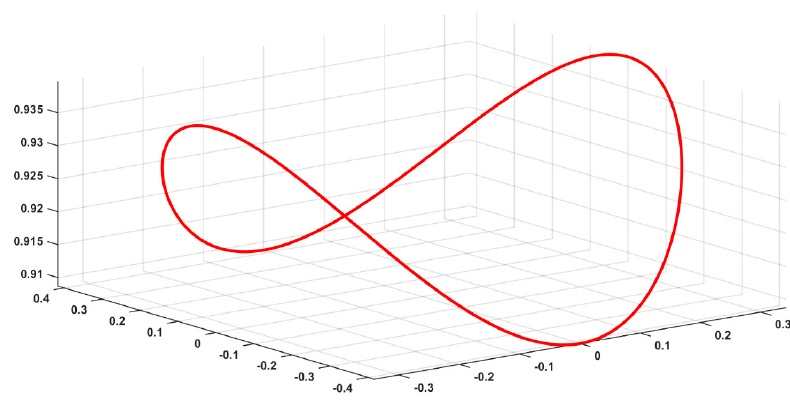
Figure A9. Axonometric view of Tomomi curve.